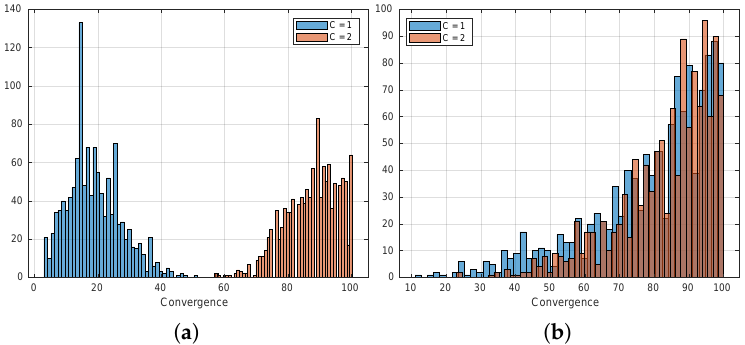
Figure A32. Histograms for the conclusions about the effect of factor C on the convergence performance, represented for the two levels of such factor with additional restrictions on the population. ( a ) Factor B = 1. ( b ) Factor B =